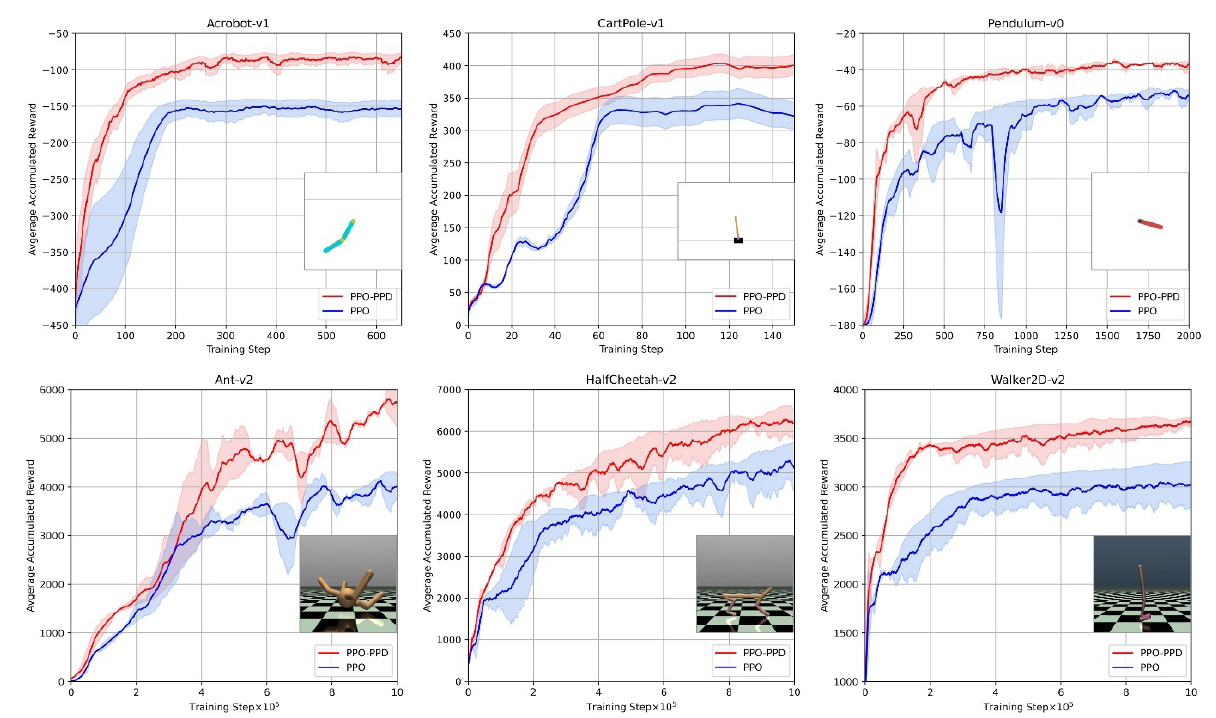
Figure 7. The average accumulated rewards obtained by PPO-PPD and PPO in different tasks. The shaded area represents the mean ± standard deviation. Table 3. The performance comparison between PPO-PPD and